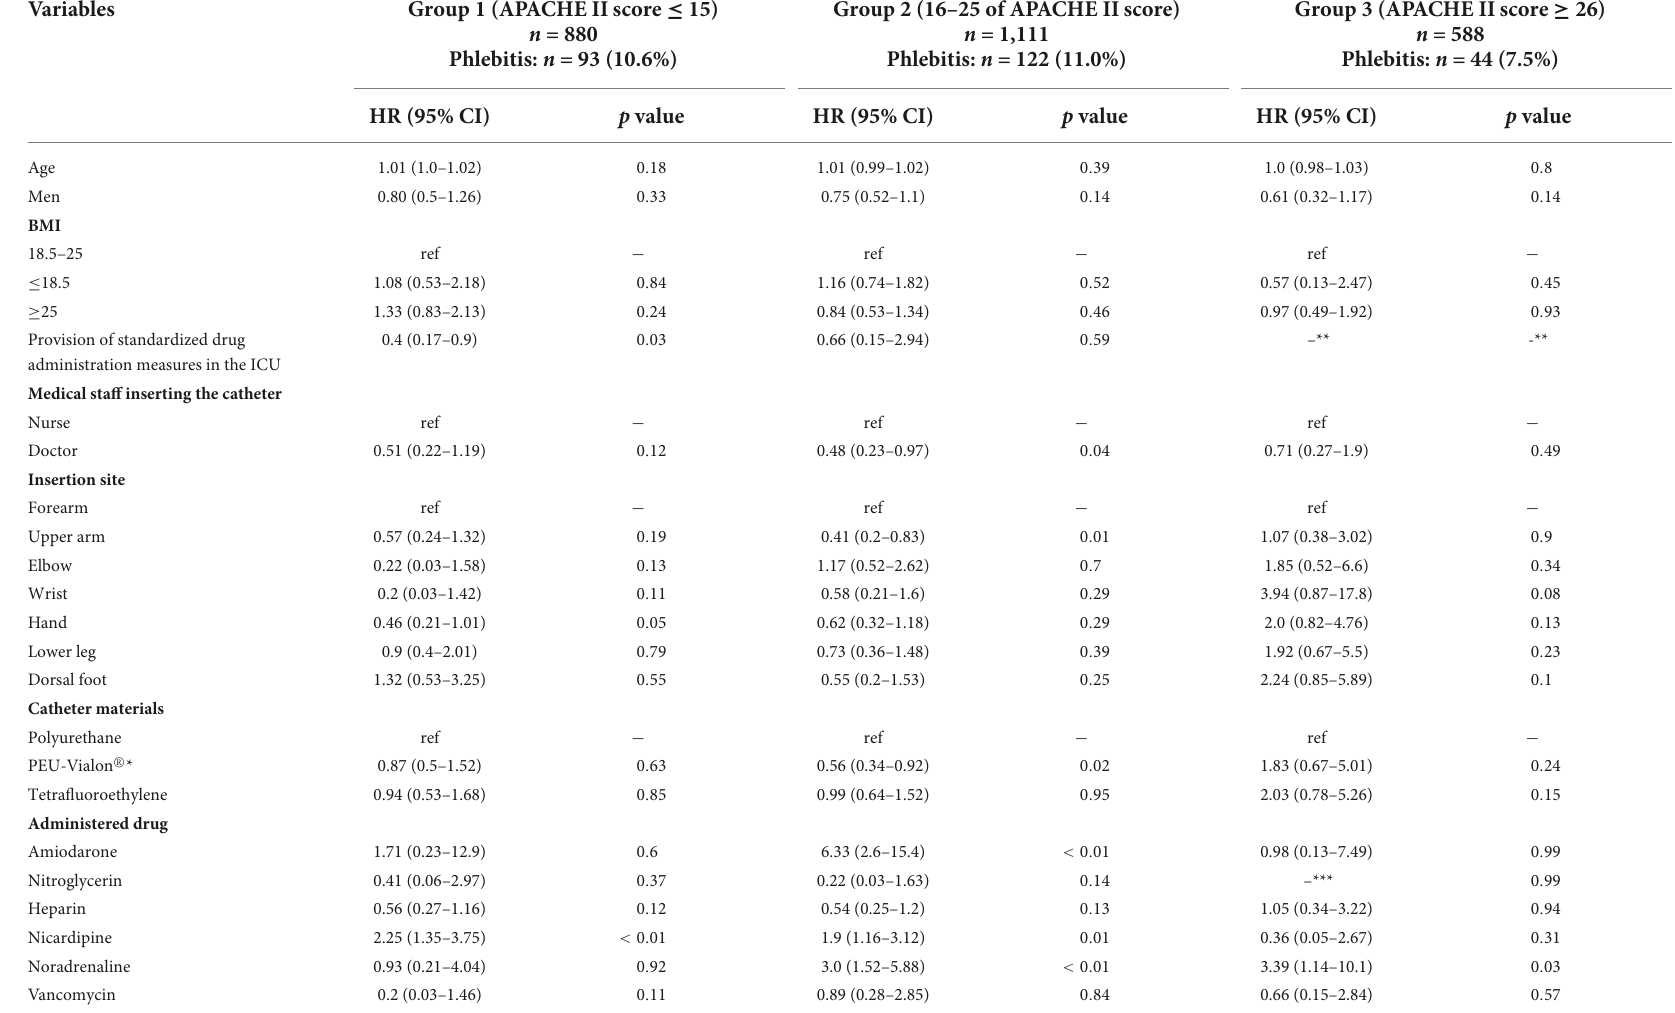
TABLE 4 Multivariable analysis for phlebitis using marginal Cox regression analysis stratified using the APACHE II score.